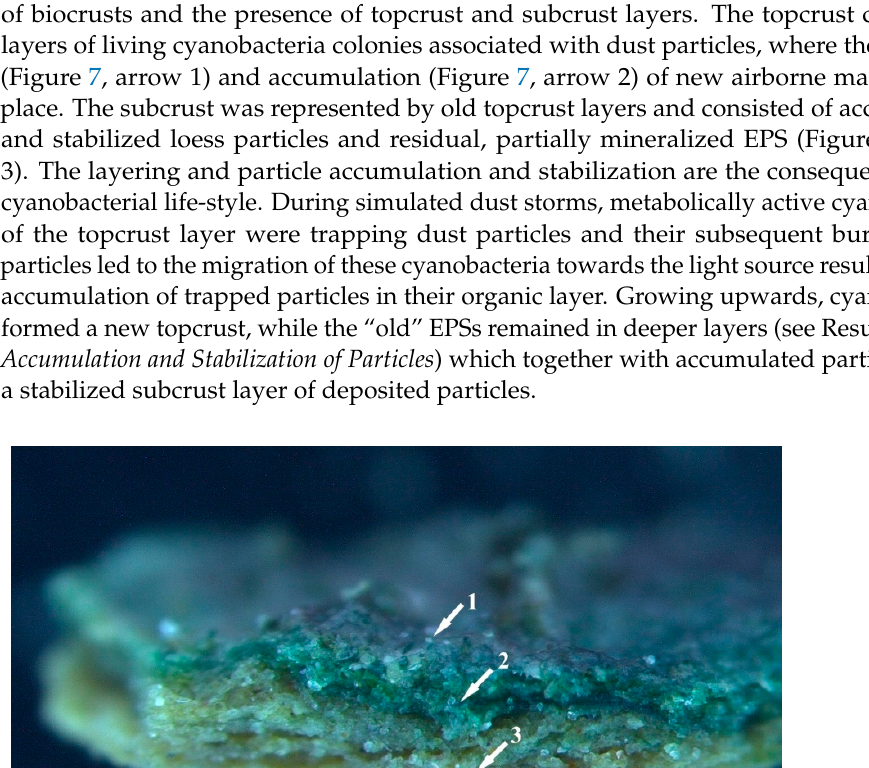
Figure 8. Trapping of particles. Three types of particle trapping were observed: net-like trapping ( A , D ), carpet-like trap- ping ( B , E ) and trapping by pinnacles ( C , F ). Cyanobacterial network connected the particles ( D , arrow 1), trapped fine particles on the exopolysaccharides (EPSs) surface ( D , arrow 2) and made pores ( D , arrow 3). Dense, carpet-like, cyano- bacterial cover ( E , arrow 3) adhered particles onto the surface of polysaccharide matrix ( E , arrow 1) and grew over the overlapping particles ( E , arrow 2). Net-like trapping : the net-like trapping (Figure 8A,D) was promoted by an extensive network of cyanobacterial filaments and the EPSs that covered, surrounded, and con- nected the particles (Figure 8D, arrow 1). Trapping of fine particles was also observed at